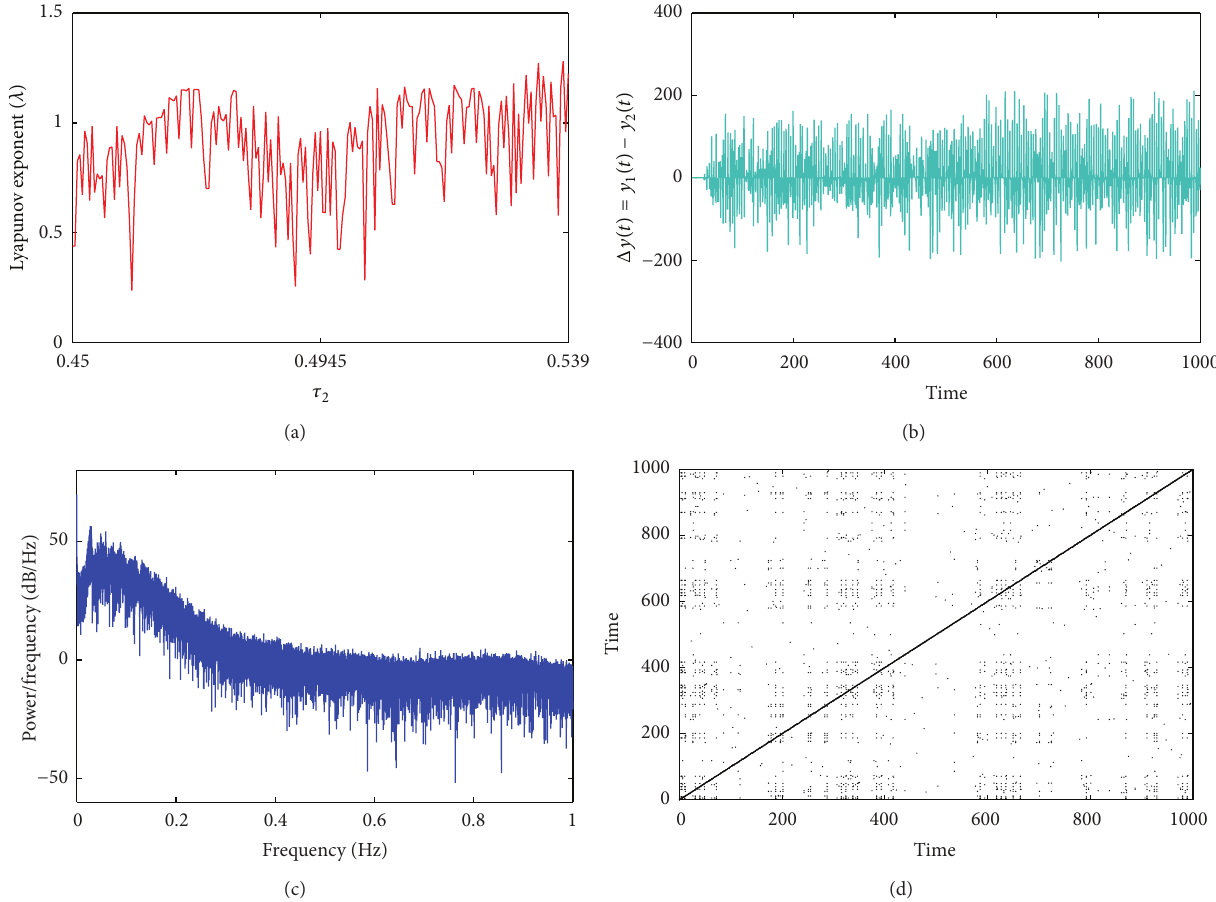
Figure 7: Standard diagnostic tests to detect chaos. (a) Lyapunov exponent, (b) sensitivity on the initial condition, (c) power spectral density, and (d) recurrence plot. Parameters are as in Figure